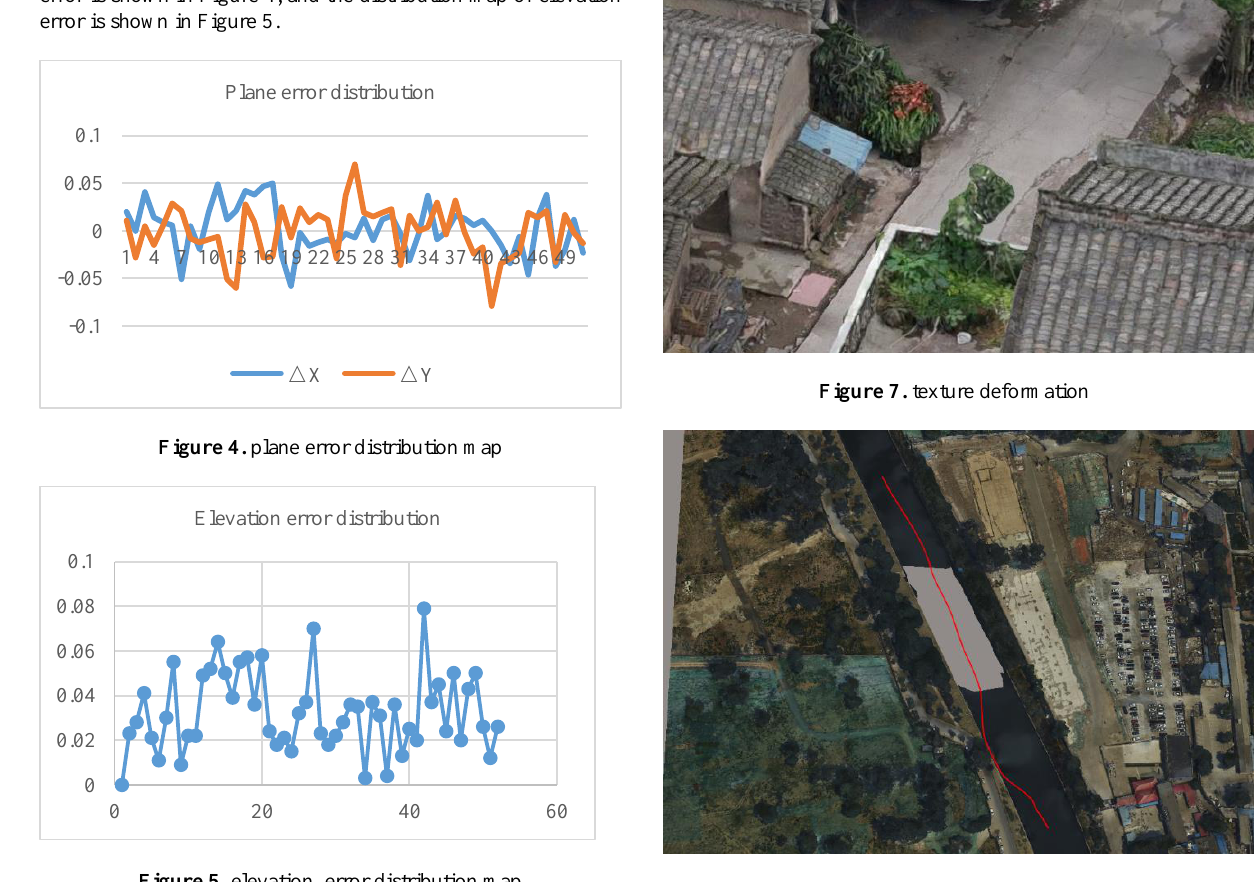
Figure 8. Model vulnerability